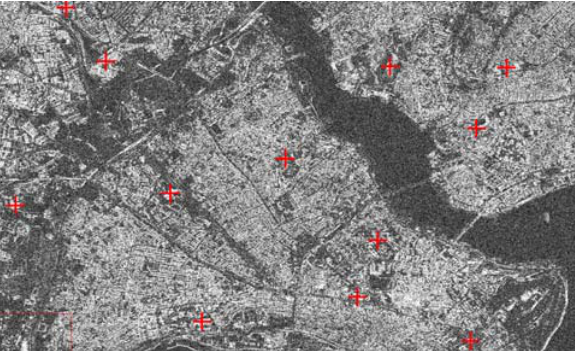
Figure 8. GCPs distribution on TSX HS interferogram and coherence